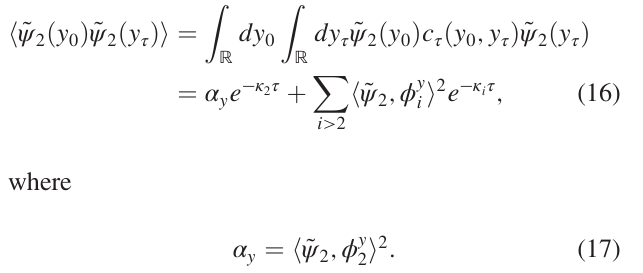
FIG. 1. Illustration of the observed dynamics for which a rate theory is formulated here. Top row: The full-dimensional dynamics x ð t Þ in phase space Ω . These dynamics are assumed to be Markovian, ergodic, and reversible as is often found for physical systems in thermal equilibrium. Furthermore, the theory here is formulated for two-state kinetics, i.e., the system has two metastable states exchanging at rates k AB and k BA , giving rise to a relaxation rate of κ 2 ¼ k AB þ k BA . Middle row: One order parameter y ð x Þ of the system is observed, such as the distance between two groups of a molecule, or the Förster Resonance Energy Transfer (FRET) efficiency between two fluorescent groups. The projection of the full-space dynamics x ð t Þ onto the order parameter y generates a time series y ð t Þ that, however, may not be directly observable. The projection also acts on functions of state space, such as the stationary distribution of configurations in full state space that is projected onto a density in the observable μ ð y Þ . The reaction coordinate quality ˆ α y measures how well the order parameter y resolves the slow transition. It is 1 when A and B are perfectly separated and 0 when they completely overlap. Bottom row: The experimental device used may distort or disperse the signal, for example, by adding noise. The resulting observed signal o ð t Þ is distorted and the observable density μ o ð o Þ is smoothed. ˆ α o measures the observation quality (OQ) of the observed signal, and it is shown in the Supplemental Material [28] that ˆ α o ≤ ˆ α y